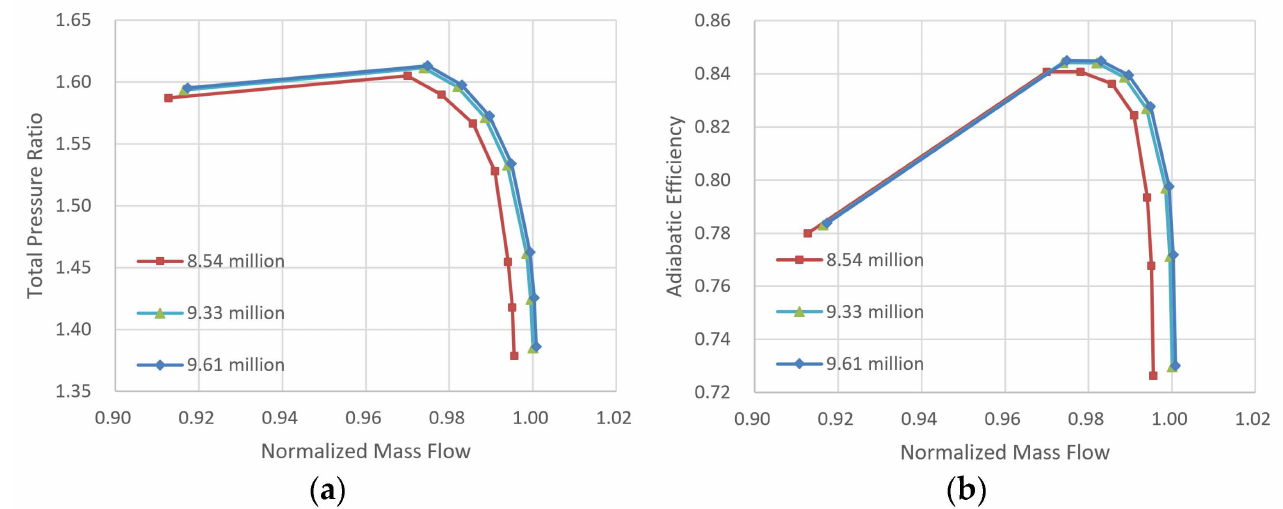
Figure 8. Comparison of the 11D compressor performance parameters obtained from different grids with the same full annulus 3D CFD scheme: ( a ) mass flow versus total pressure ratio, and ( b ) mass flow versus adiabatic efficiency.